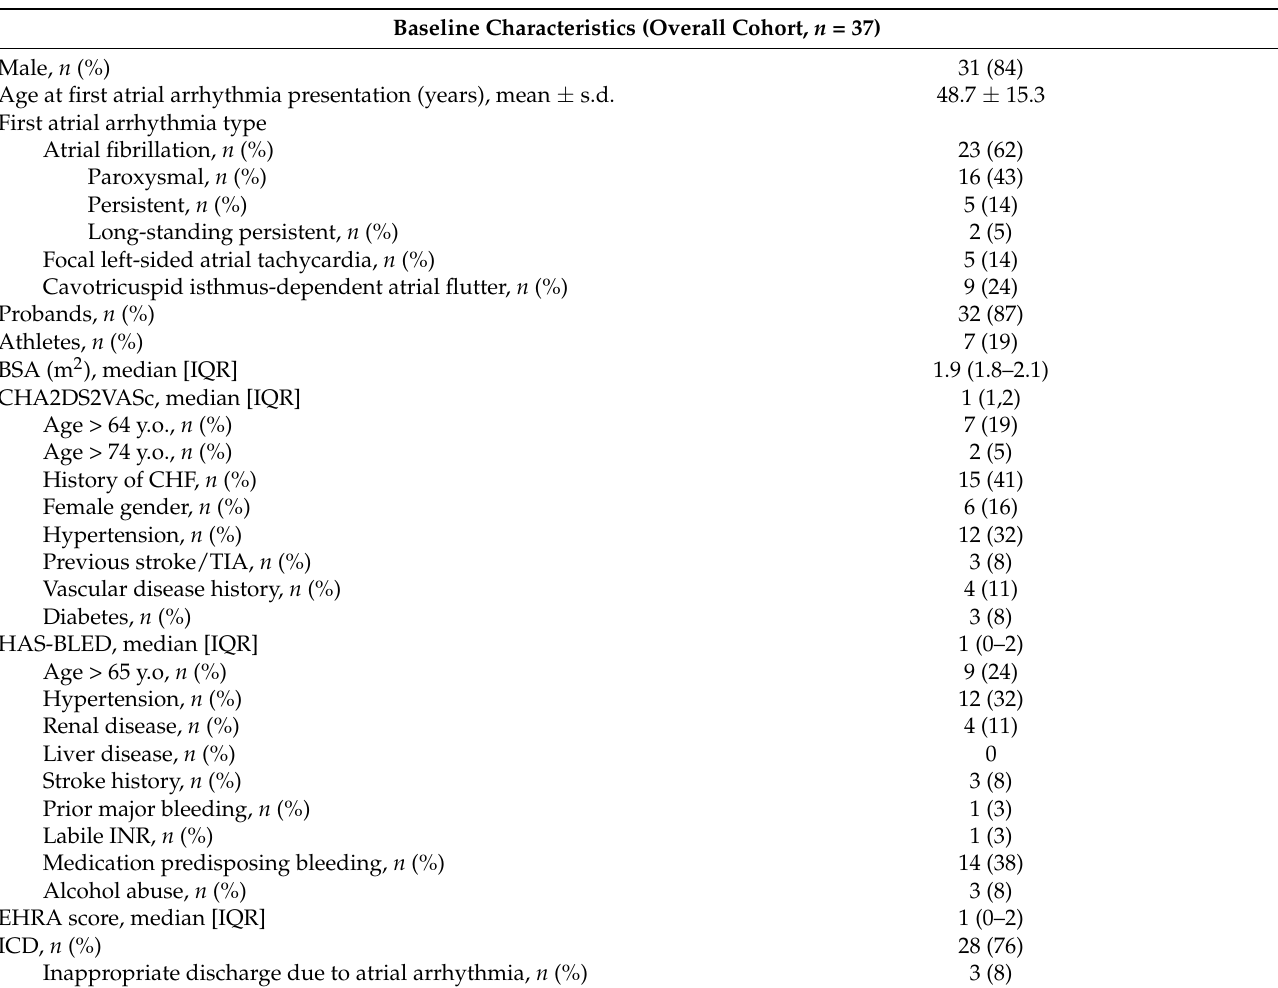
Table 2. Baseline clinical characteristics for the study